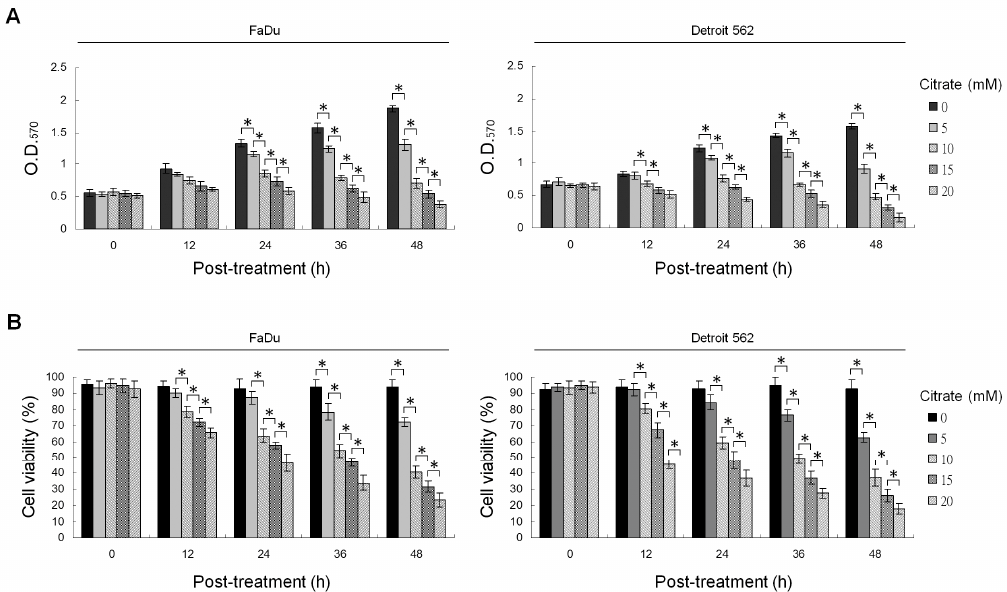
Figure 1. Citrate inhibits the growth of human pharyngeal squamous carcinoma (PSC) cells. ( A,B ) Cytotoxic and growth-inhibitory effects of citrate on PSC cells. The cells were treated with vehicle or the indicated concentrations of citrate for the indicated periods of time. Cell viability and proliferation were determined by flow cytometric analysis of propidium iodide (PI) uptake and MTT assay, respectively. The values are presented as the means ± standard error of three independent experiments. * p < 0.05: significantly different from vehicle ( − )-treated cells.